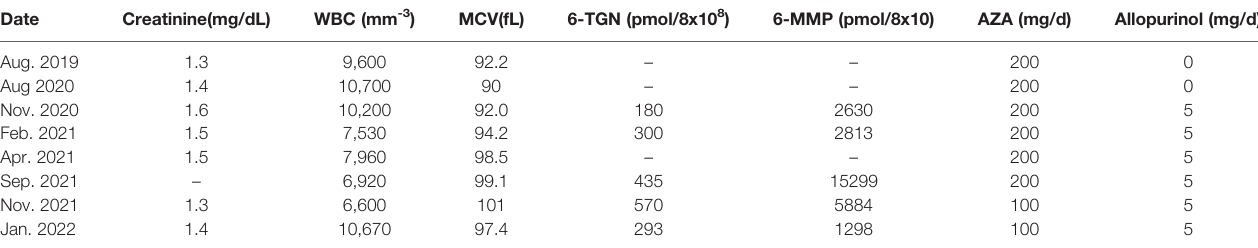
TABLE 2 | Patient with low 6-TGN despite apparently adequate dose of